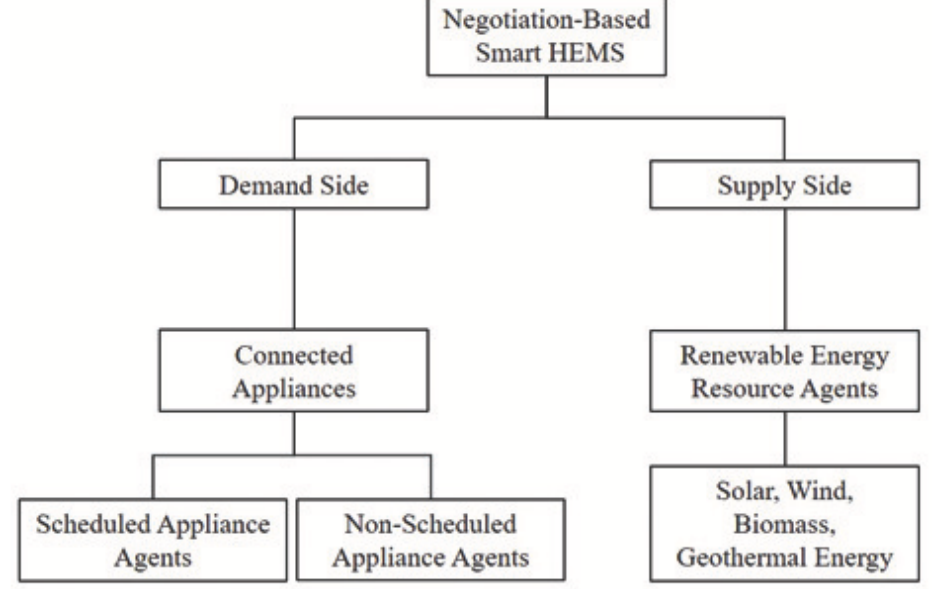
Figure 4. Agent architecture for smart home energy